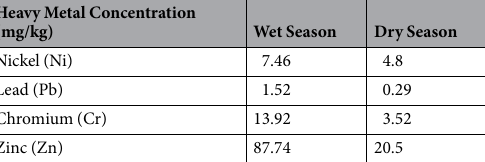
Table 3. Soil Background Heavy Metals for Dry and Wet Season in the Study Area.